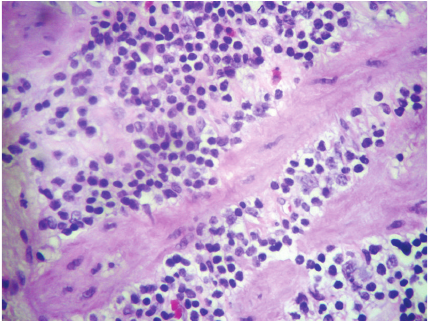
Figure 2: Immunohistochemistry ( ×200 ) showing CD23 positive cells infiltrating the gallbladder wall.